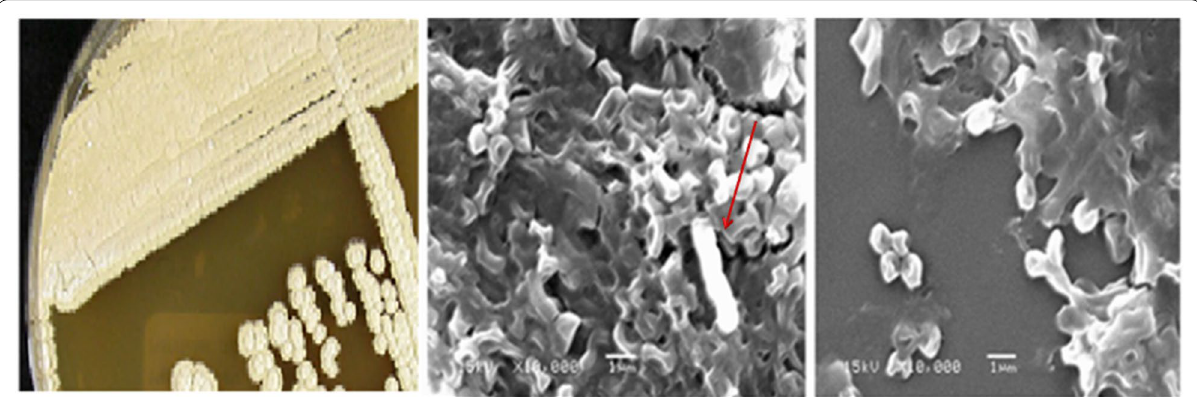
Fig. 1 Colony morphology of AN‑coded isolate on LB agar plate incubated at 30 °C for 3 days (left) and SEM micrographs (middle and right). The red arrow pointed to the spore structure‑like sporangium